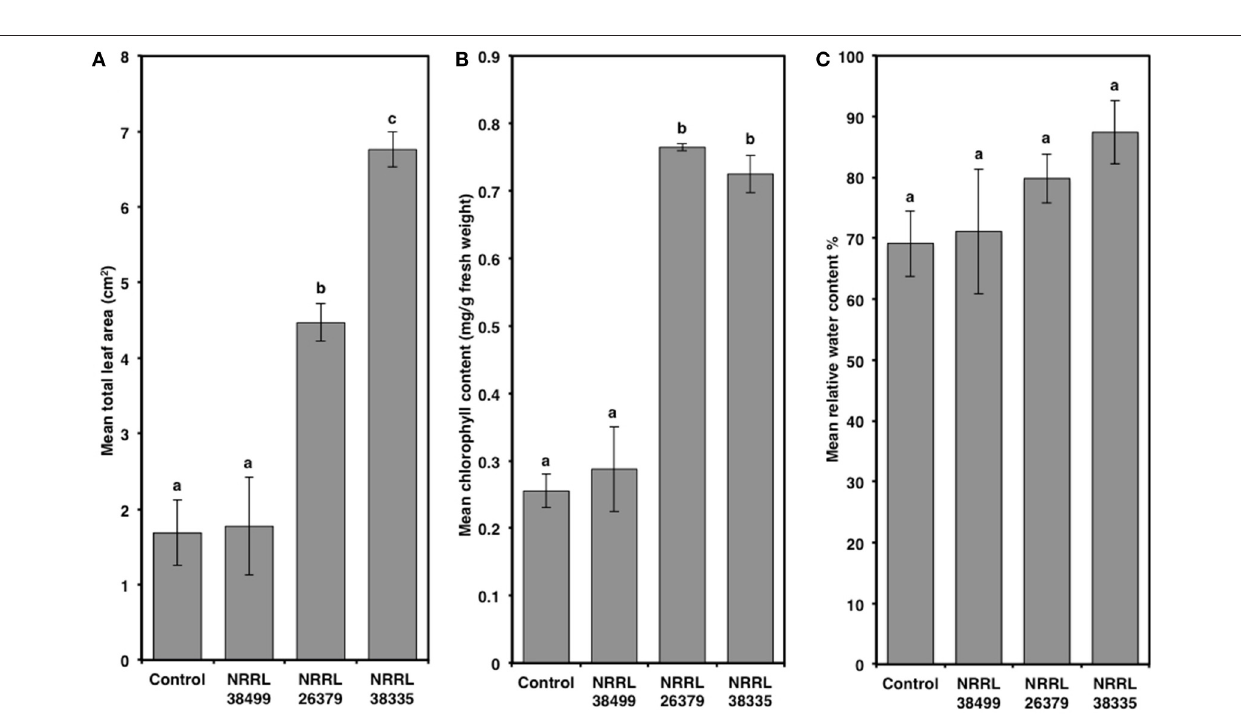
Frontiers in Microbiology | www.frontiersin.org